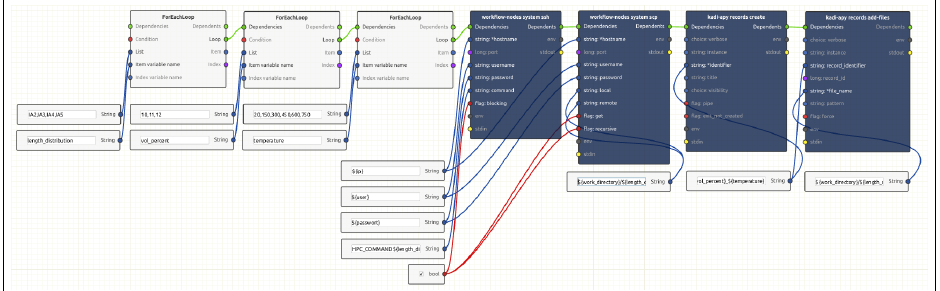
Figure 15. Exemplary Kadi4Mat workflow for conducting the simulation study and persisting the results in the Kadi4Mat